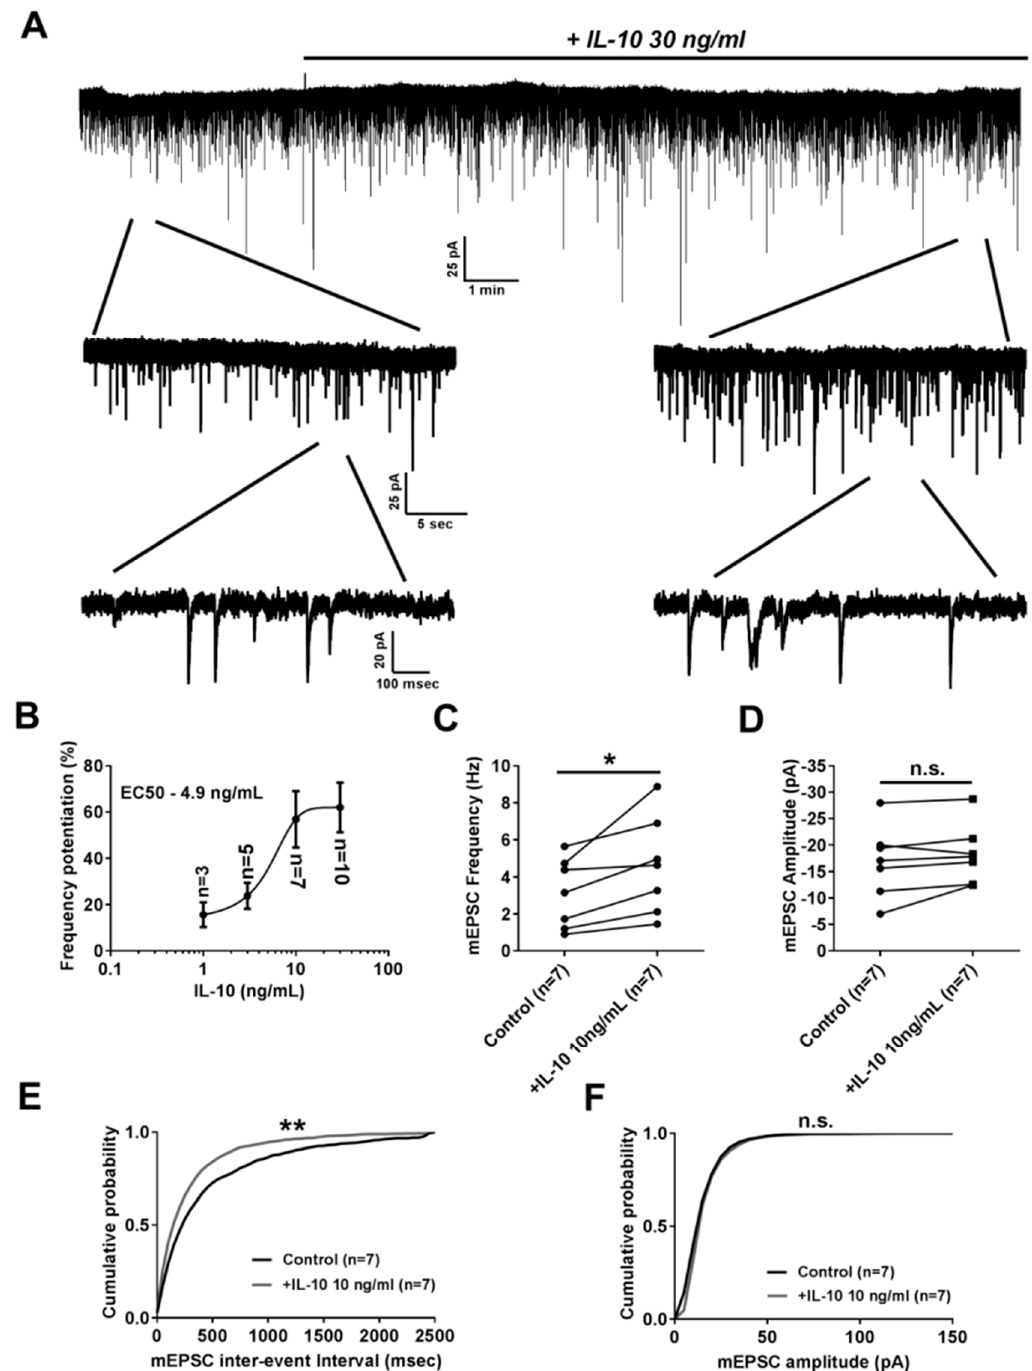
Figure 1. IL-10 presynaptically facilitates basal glutamatergic synaptic transmissions. ( A ) Representative traces of miniature excitatory postsynaptic currents (mEPSC) presented at different time scales. Exposure to IL-10 is indicated with a solid line. ( B ) Dose-dependent curve of IL-10 action on mEPSC frequency. ( C ) Graphical plot representing mEPSC frequency before and 15 min after IL-10 application. ( D ) Graphical plot representing mEPSC amplitude before and 15 min after IL-10 application. ( E ) and ( F ) Cumulative probability distribution plots representing mEPSC inter-event interval ( E ) and amplitude ( F ) distributions before and 15 min after IL-10 application. * p < 0.05 with paired t -test; ** p < 0.01 with Kolmogorov–Smirnov test.